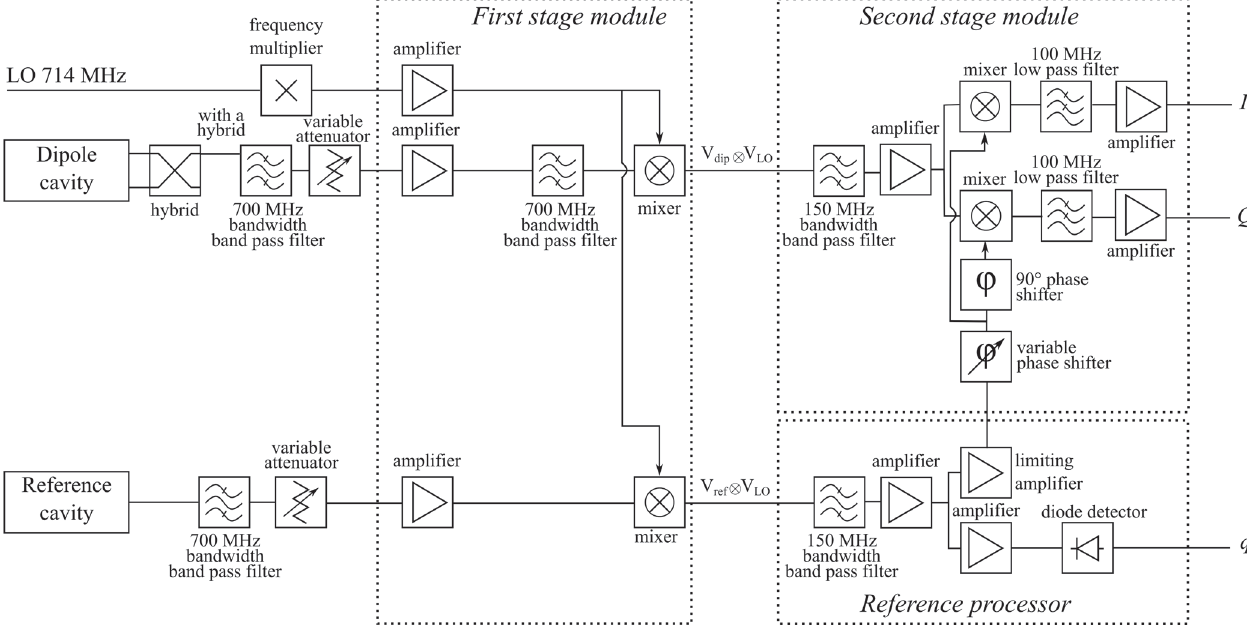
6. Simplified block diagram of the two-stage down-mixing process of the dipole and reference cavity signals from GHz-level to baseband. The 700 MHz bandwidth band pass filters on the dipole cavity signal are centered on the dipole cavity frequency, f those on the reference cavity signal are centered on the reference cavity frequency, f